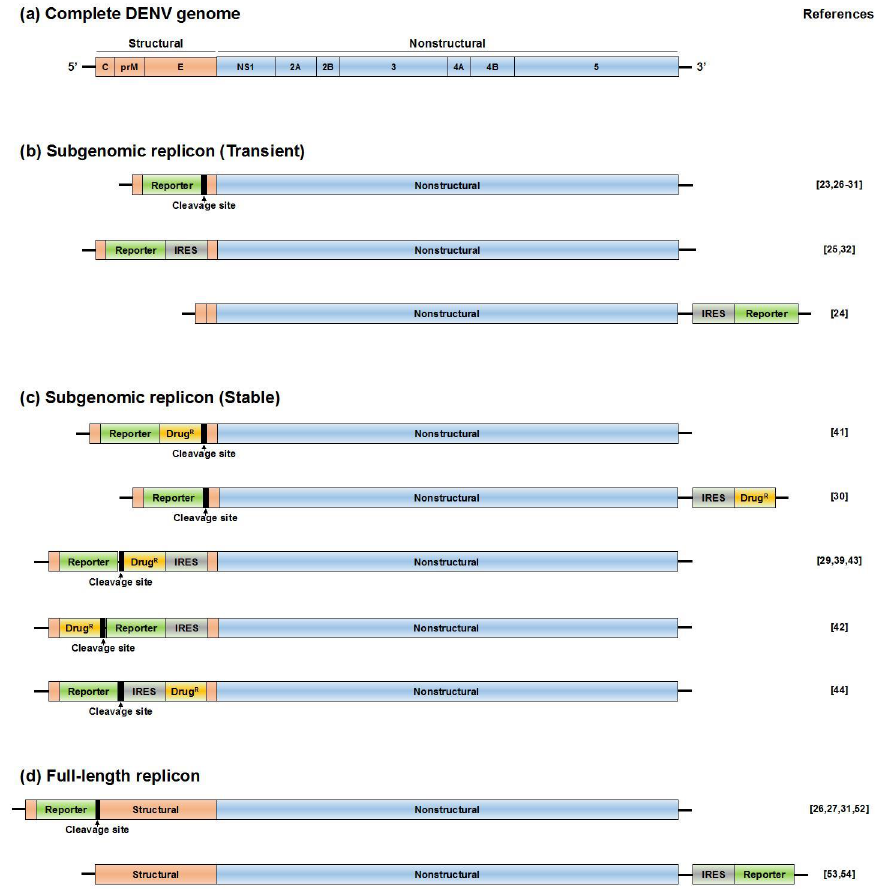
Figure 3. Schematic diagram of DENV reporter replicons. ( a ) Structure of the complete DENV genome; ( b ) subgenomic reporter replicons that are used for transient replication assays; ( c ) selectable subgenomic reporter replicons. The RNA supports stable expression of reporter and nonstructural (NS) proteins; ( d ) full-length reporter replicons that produce infectious viral particles. Reporter genes: Renilla (Rluc), firefly (Fluc), or Gaussia luciferase (Gluc) or green fluorescence protein (GFP); cleavage site: foot-and-mouth disease virus (FMDV) 2A or ubiquitin cleavage sequence; IRES: internal ribosome entry site; Drug R : drug-resistance